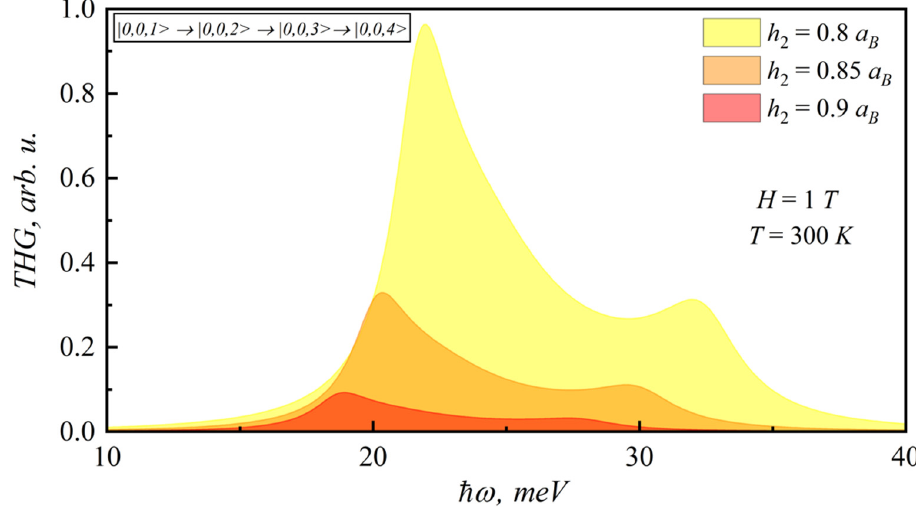
Figure 12. Dependence of THG coefficient on photon energy for different lens-shaped QD heights.